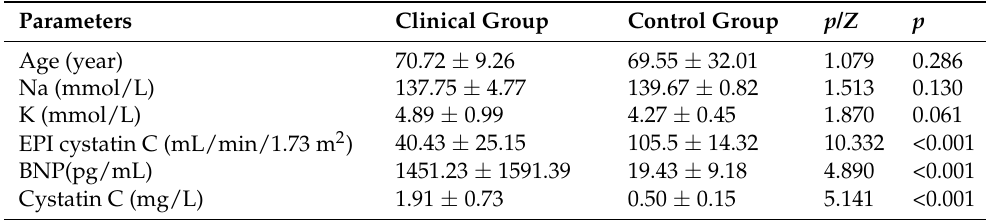
Table 2. Demographic values and values of laboratory parameters of patients in the clinical and control groups.